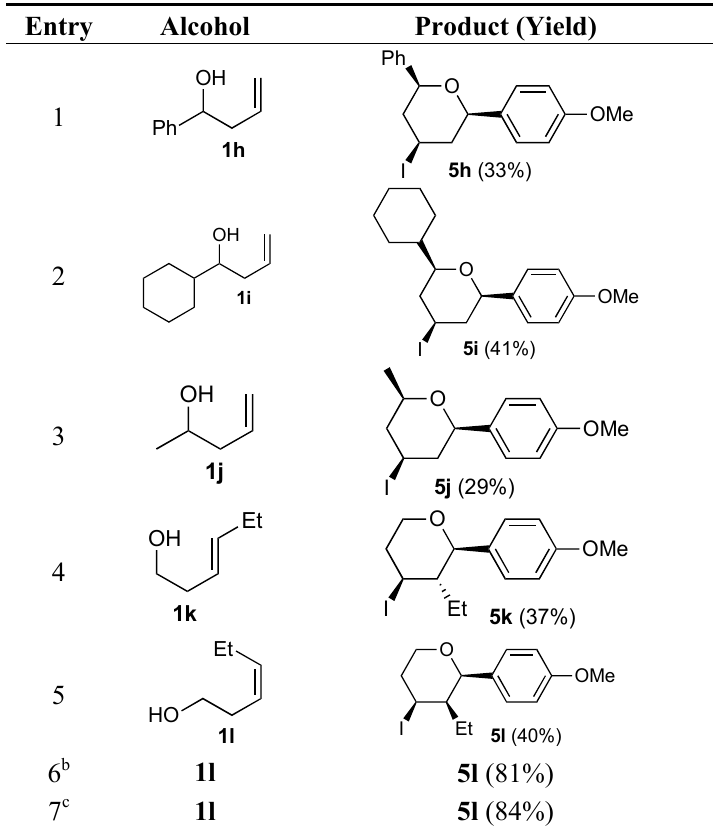
Table 5. Iodine-catalyzed Prins cyclization of acyclic homoallylic alcohols with 2b a